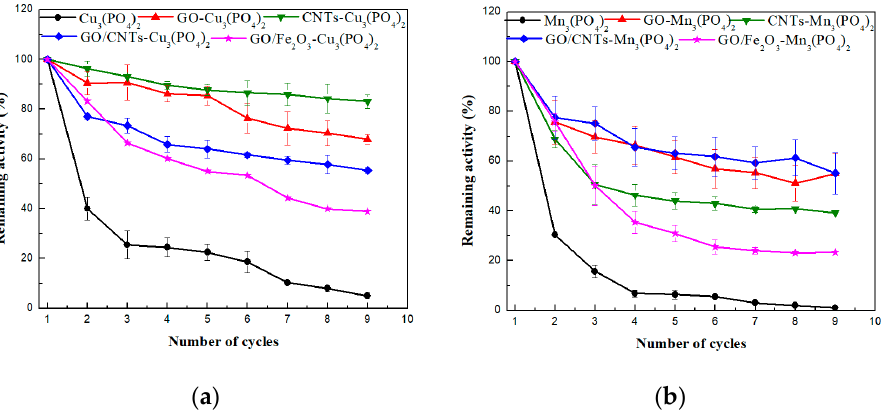
Figure 5. Operational stability of: ( a ) Cu 3 (PO 4 ) 2 -based CaLB-HNFs and ( b ) Mn 3 (PO 4 ) 2 -based CaLB-HNFs. The 100% percentage corresponds to the lipase hydrolytic activity at the first catalytic cycle.